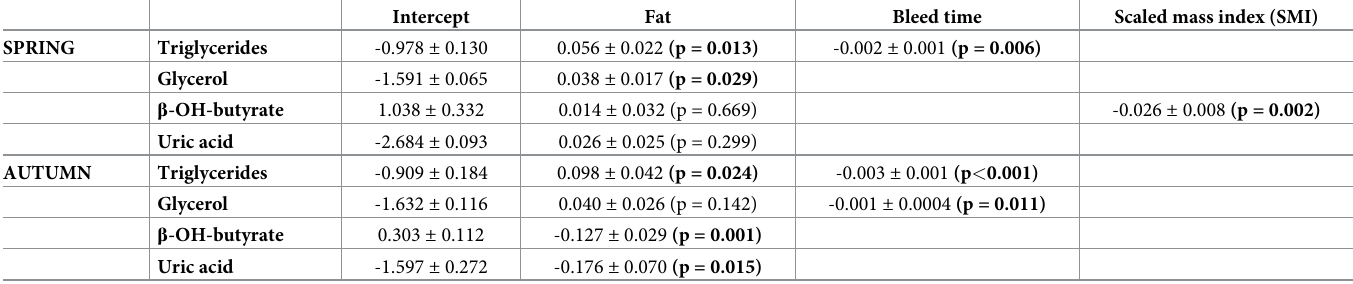
Table 3. Results of the minimum adequate model derived by comparison of nested generalized linear models explaining the relationships between plasma metabo- lite concentrations and fat scores of migrant dunlins in spring and autumn migratory periods.